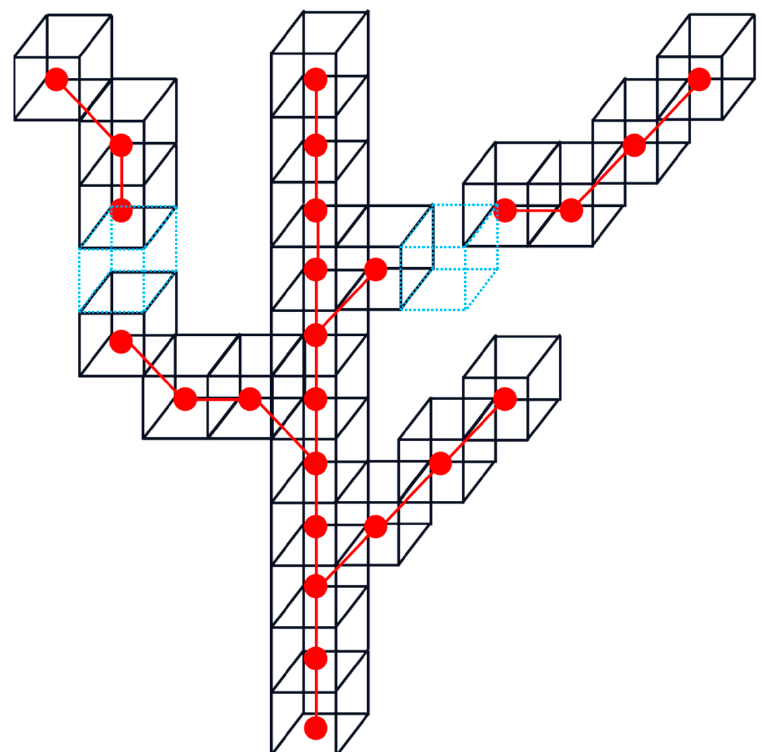
Figure 4. Schematic diagram of raw skeleton construction. Red point: tree skeleton node; red line: the connection of skeleton nodes; black box: voxel containing some wood points; blue box: an empty voxel.